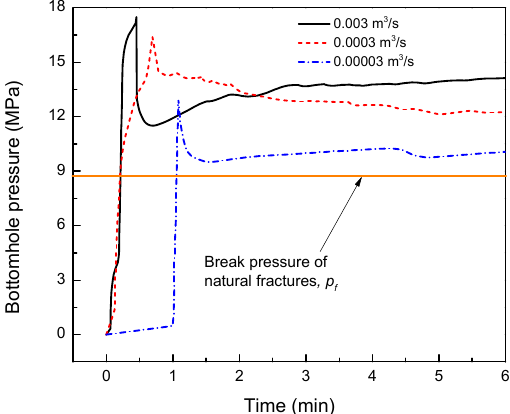
Figure 15. The bottomhole pressure variations at different injection rates. The figure shows that the stable bottomhole pressure and the break-down pressure increased as the injection rate increased.